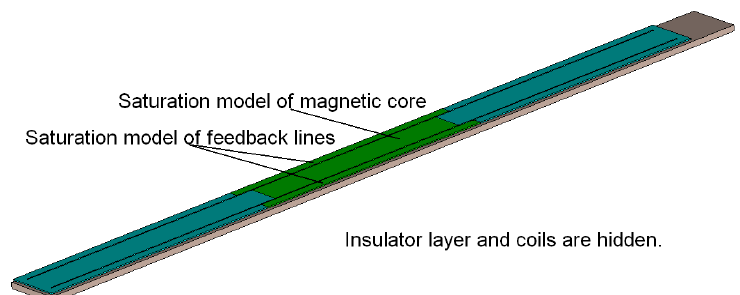
Figure 12. Magnetic saturation region models.